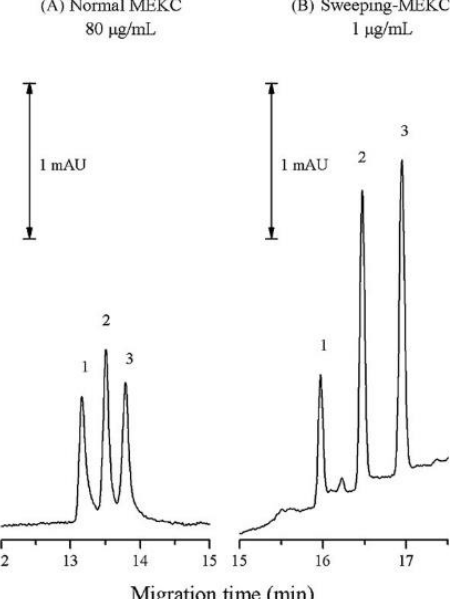
Figure 4. Comparison between the normal MEKC and sweeping-MEKC methods for simultaneous separation of THC and its metabolites (analytical conditions ( A )—25mM citric acid/disodium hy- drogenphosphate BGE, 75 mM SDS, pH 2.6, 40% methanol, 25 ◦ C, − 20 kV, injection 3.45 kPa × 3 s, sample concentration, 80 µ g/mL; ( B )—25mM citric acid/disodium hydrogenphosphate BGE, 75 mM SDS, pH 2.6, 40% methanol, 25 ◦ C, − 20 kV, injection 3.45 kPa × 300 s, sample concentration, 1 µ g/mL). Peaks: (1) THC; (2) THC-COOH; (3) THC-OH. The figure is reproduced from Su et al. [36] with permission from Elsevier.